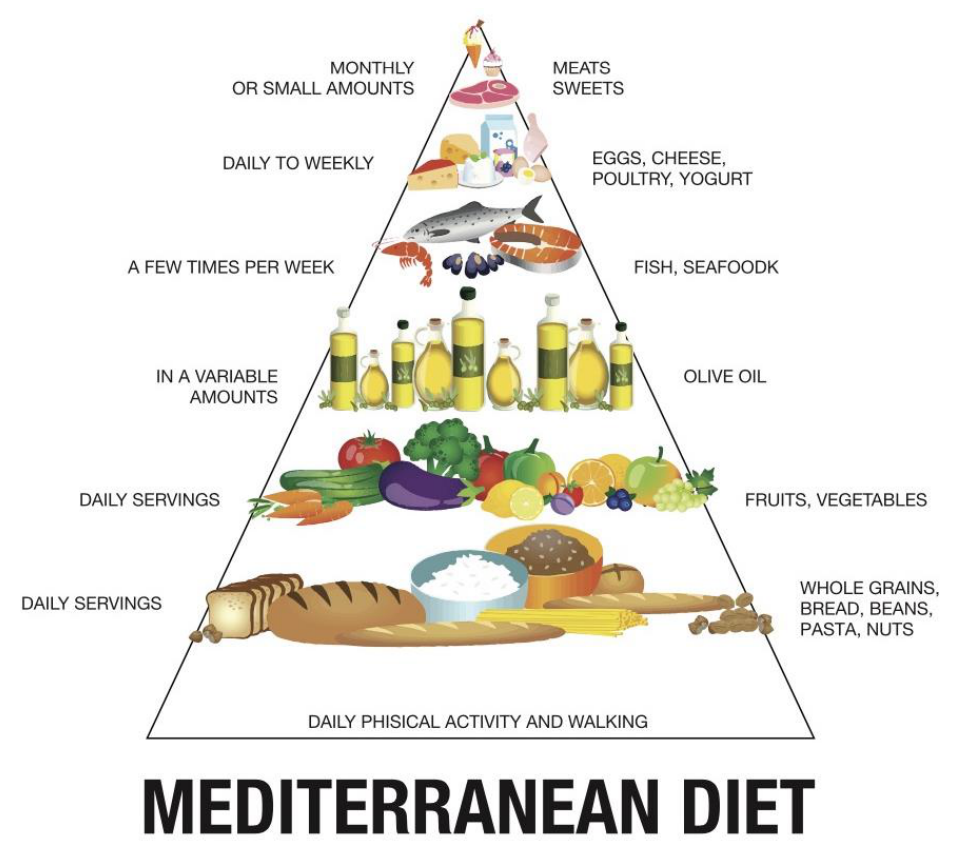
Figure 2. Image that represents the food pyramid typical of the Mediterranean diet. TMD is full of fruits and vegetables with an abundant consumption of olive oil. The pyramid describes, to varying degrees, which foods should be taken daily and which require monthly or infrequent intake.